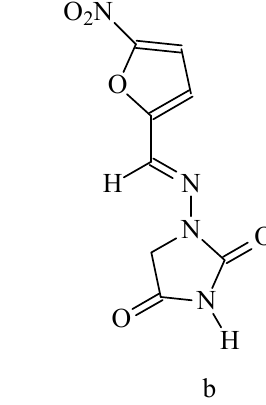
Figure 4. Molecular structure of reference drugs.